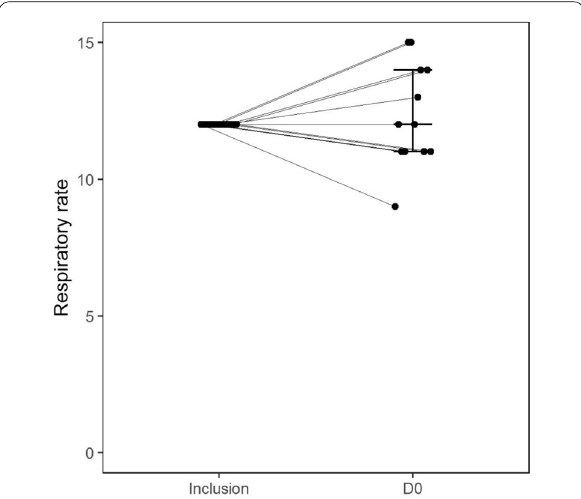
Fig. 2 Respiratory rate before ECCO 2 R initiation and after ECCO 2 R initiation and adjustment aiming to improve arterial pH value. D0: first day with ECCO 2 R, after adjustment of respiratory rate aiming to improve arterial pH